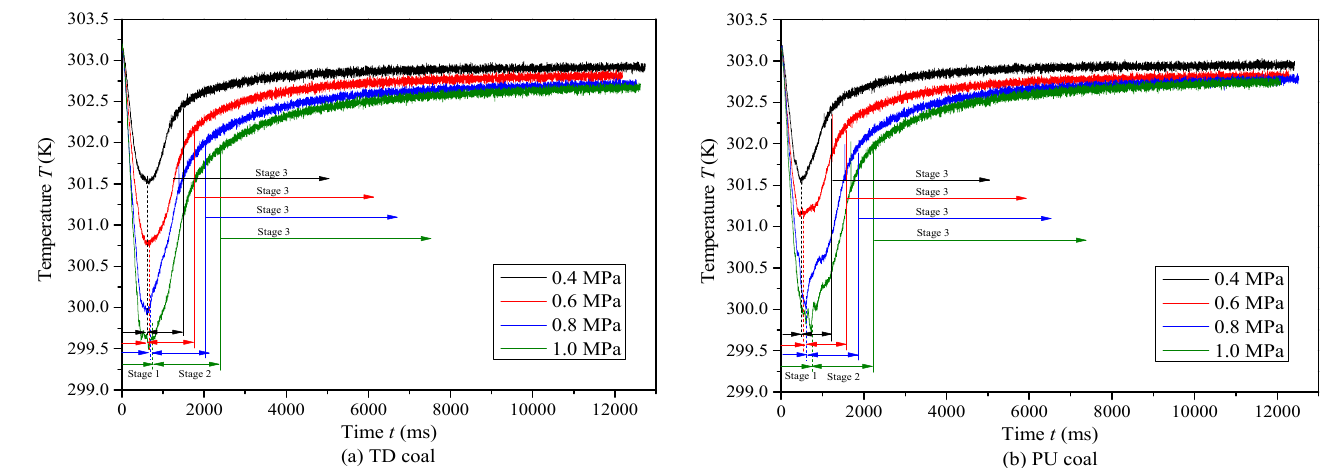
Figure 4. Change curve of temperature with time during the gas initial desorption of coal particles.